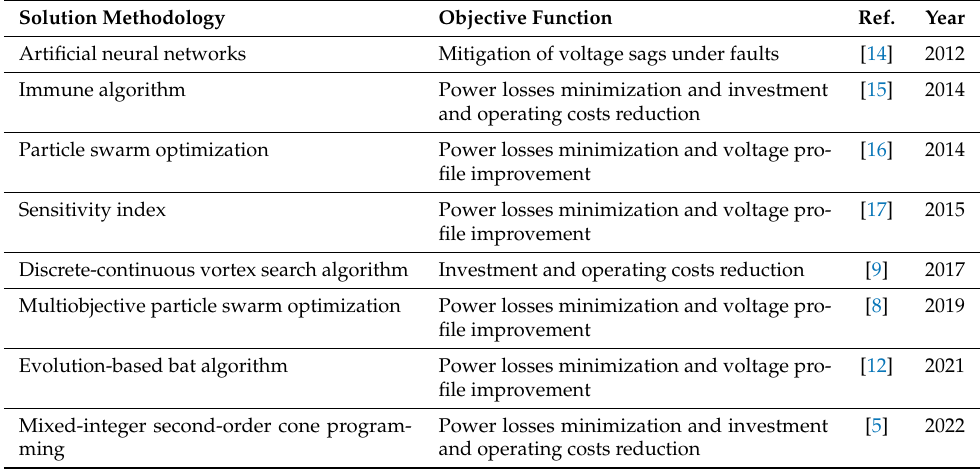
Table 1. Summary of methodologies used in the literature for the placement and sizing of D-STATCOMs. Solution